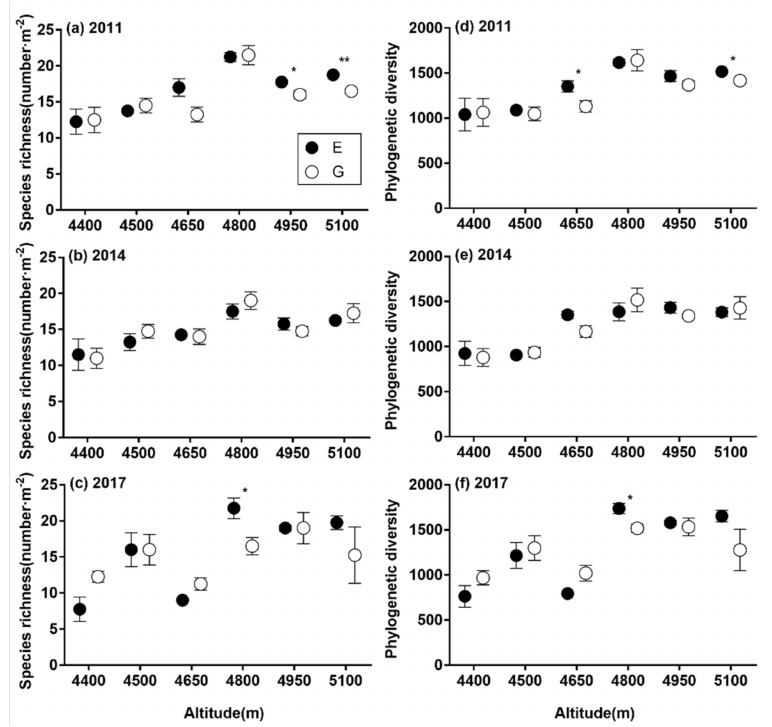
Figure 4. Differences in ( a – c ) species richness and ( d – f ) Faith’s phylogenetic diversity between enclosure and grazing along the altitudinal gradient among different years. Solid circles are for enclosure, and blank circles are for grazing plots. Asterisk denotes the significant difference between enclosure and grazing. * P < 0.05, ** P < 0.01, *** P <